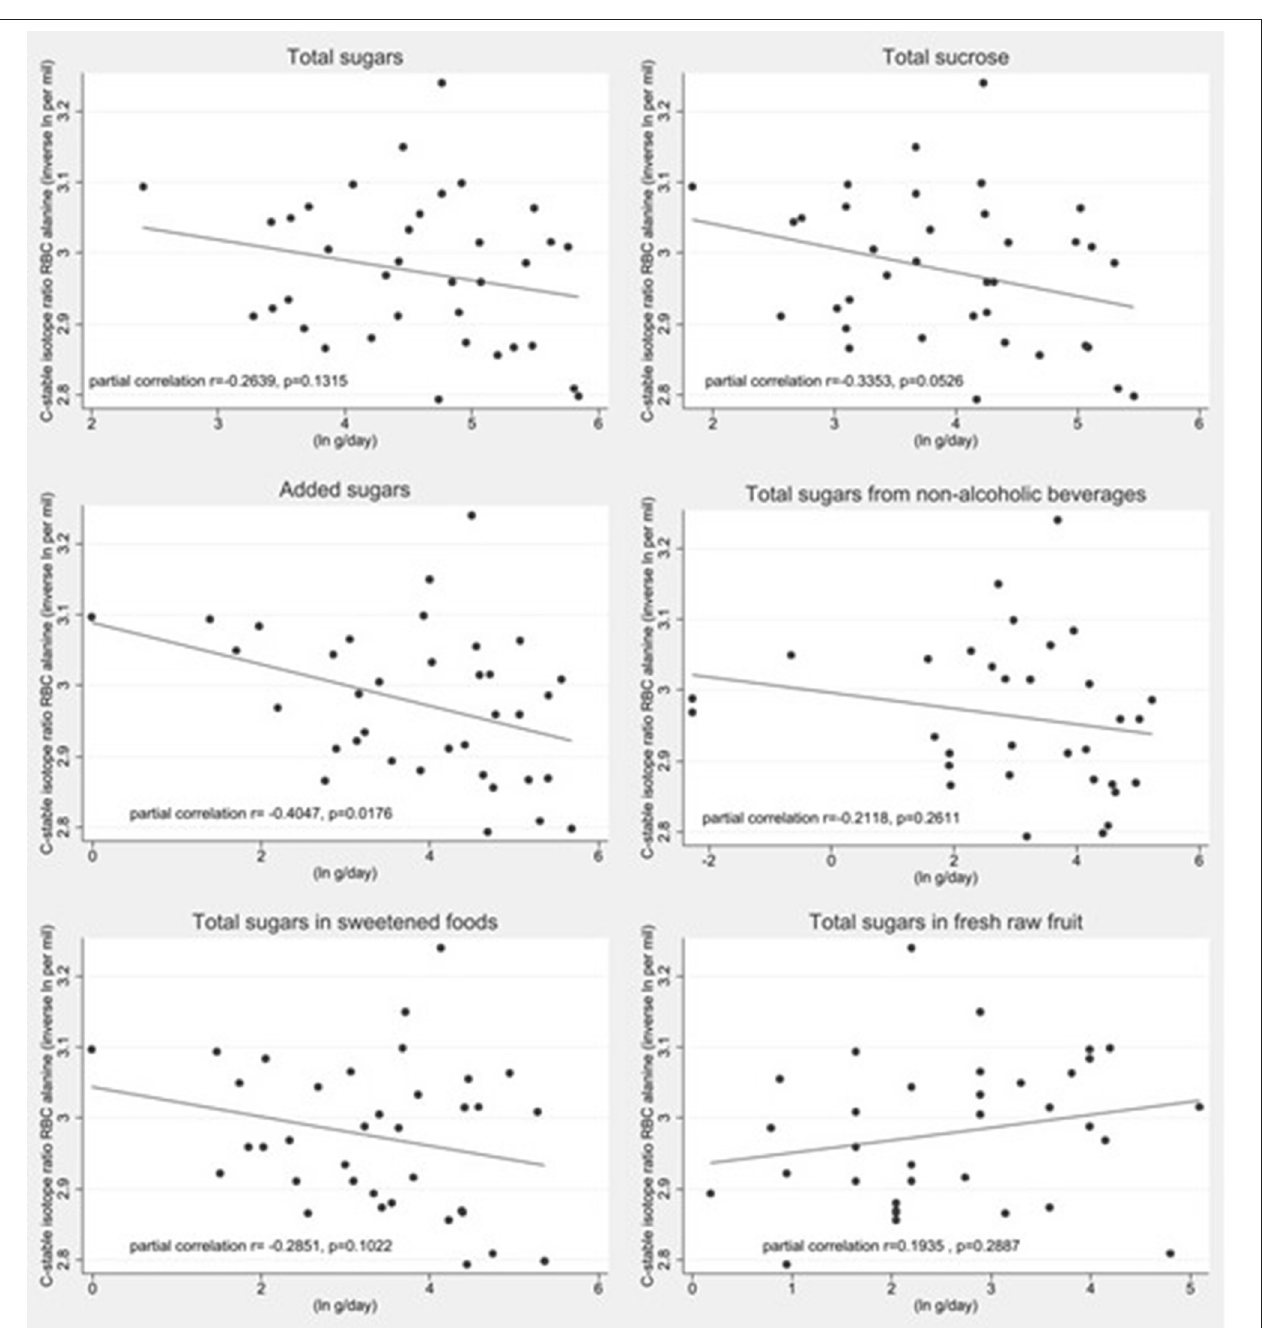
FIGURE 2 | Scatter plots of the log transformed additive inverse δ 13 C alanine values by log transformed sugars intake estimates estimated by a sugar specific FFQ ( n = 36). The dashed represents the linear fit model. Partial correlation values after controlling for δ 15 N RBC are presented within each plot.